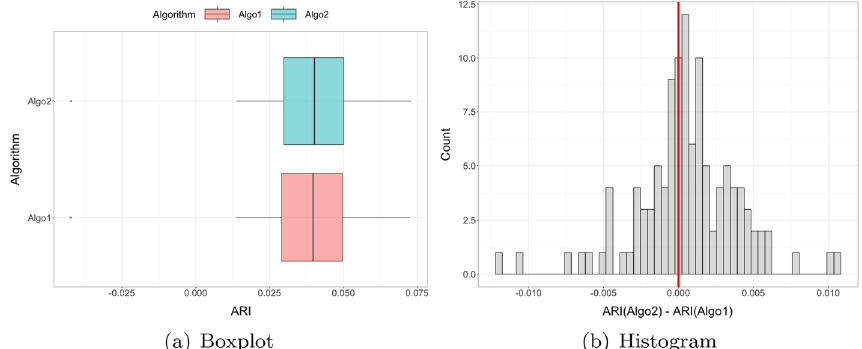
Fig. 6 Algorithms’ comparative performance on diffusion MRI connectome data via ARI with initial sampling 0.25 and dynamic network sampling parameter p 1 parameter p 0 =